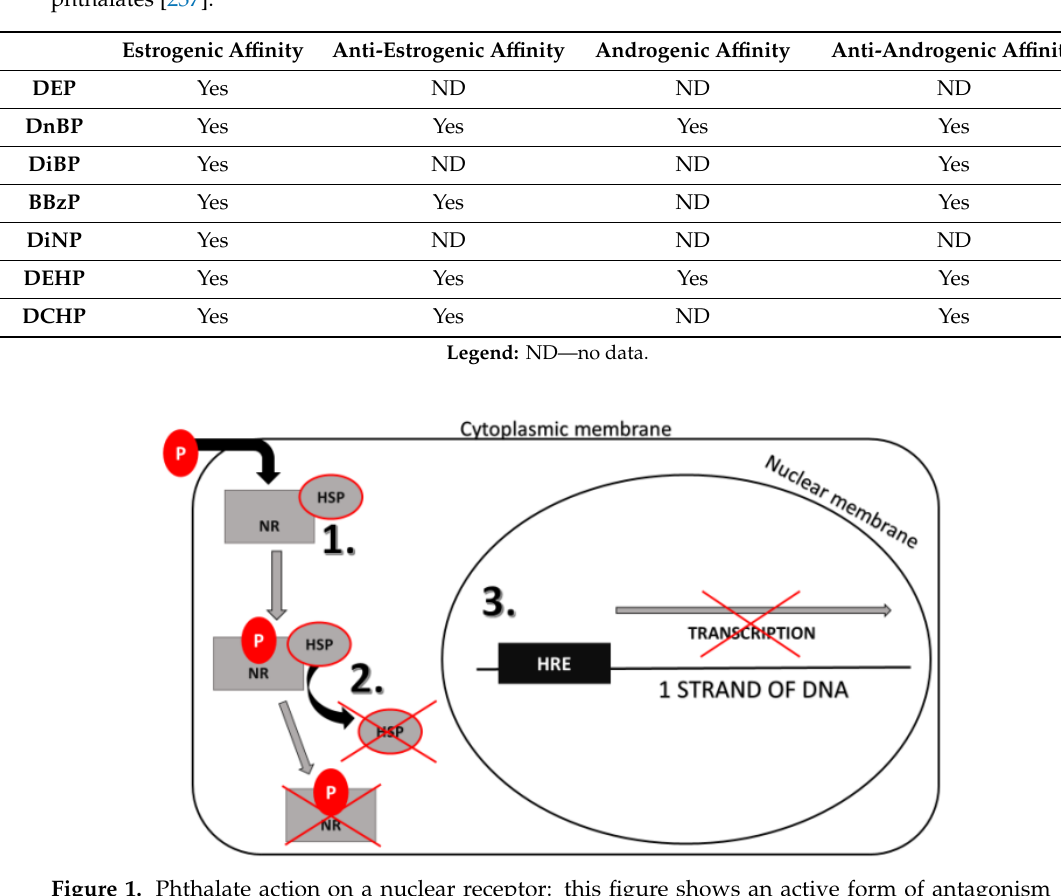
Figure 2. Phthalate action on nuclear receptors: this figure shows another form of antagonism when P prevents the NR from forming the correct conformation to activate the co-activators of transcription and thereby inhibit transcription. 1. P binds to the NR; 2. HSPs dissociate from the P-NR complex; 3. Co-activators cannot bind to the P-NR complex and therefore inhibit transcription; HRE-hormone response elements; HSP-chaperones, NR-nuclear receptor, P-phthalate. Table 5. Estrogenic/anti-estrogenic and androgenic/anti-androgenic affinity of the selected phthalates [237].